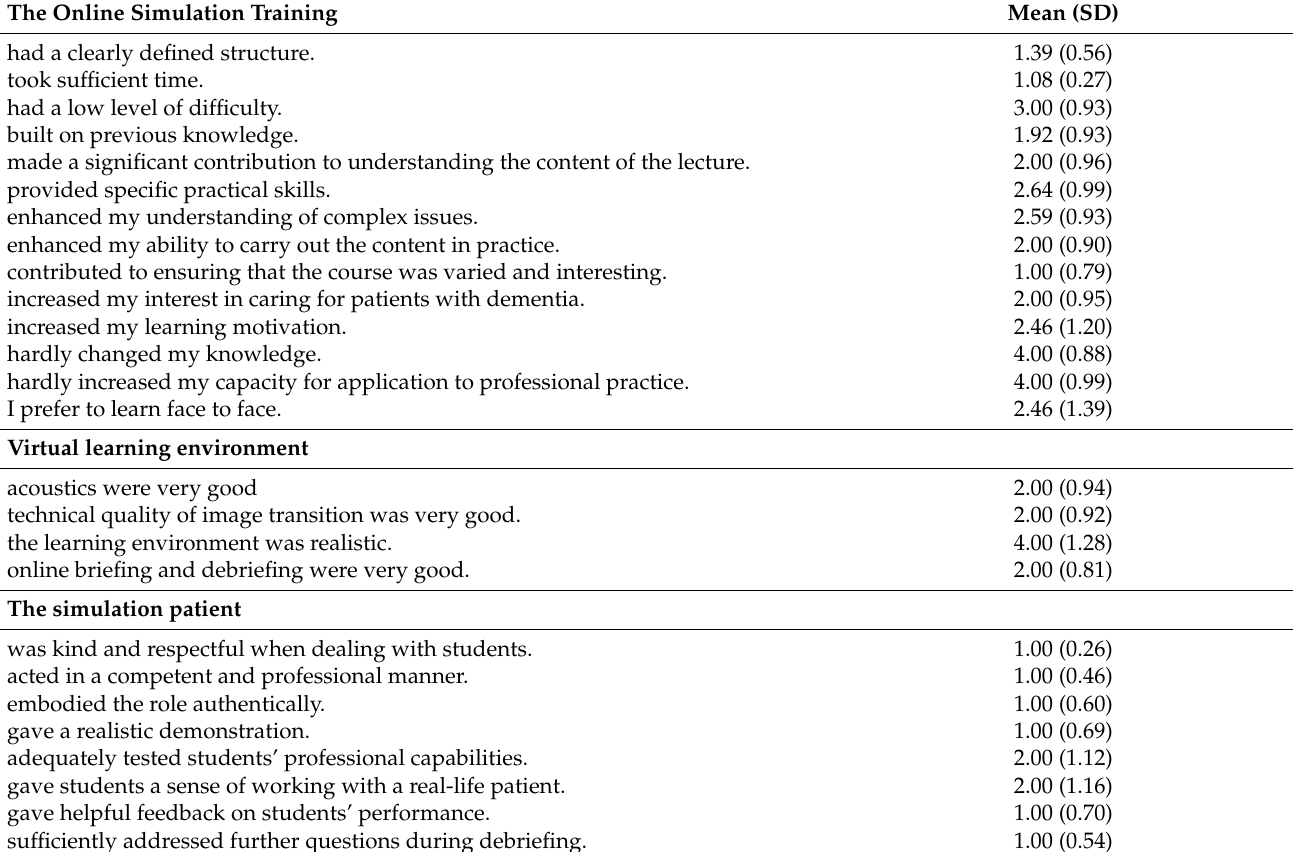
Table 4. Evaluation of the online simulation